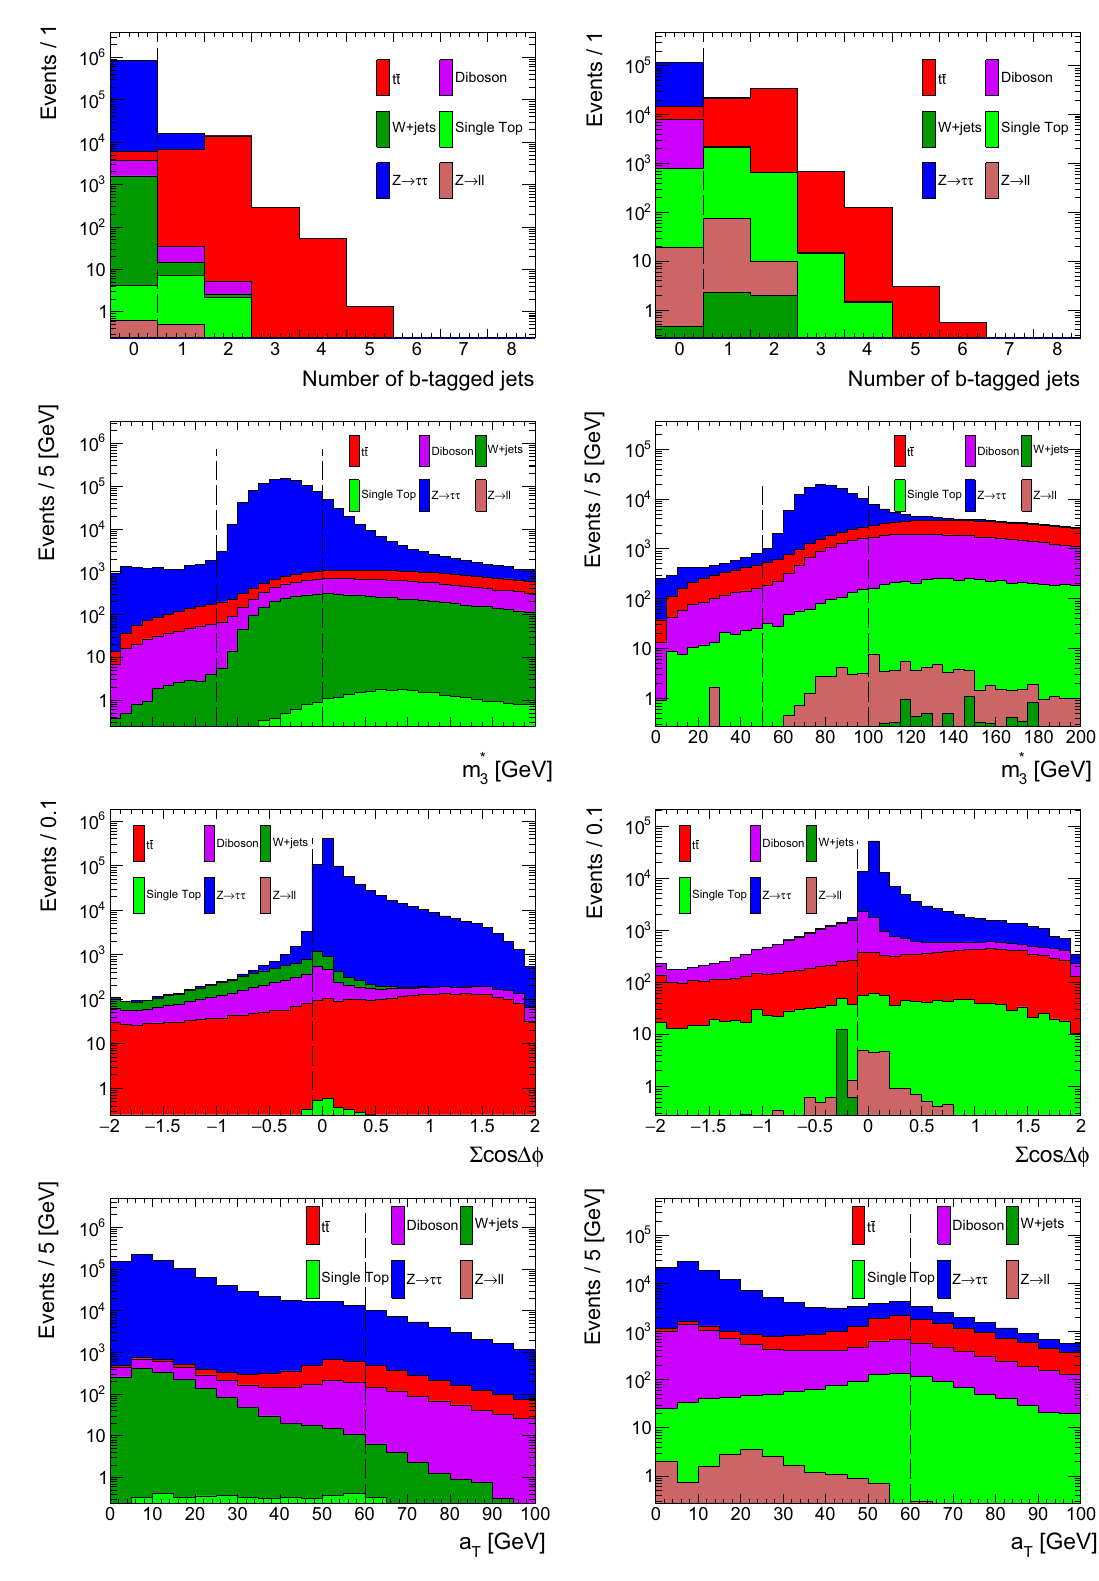
Fig. 4 Distributions of variables in the selection of Z /γ ∗ → ττ candidate events having applied all other selection criteria. The left column shows Z → ττ → (cid:2)τ had candidate events. The right column shows Z → ττ → e μ candidate events. The selection criteria are indicated by vertical